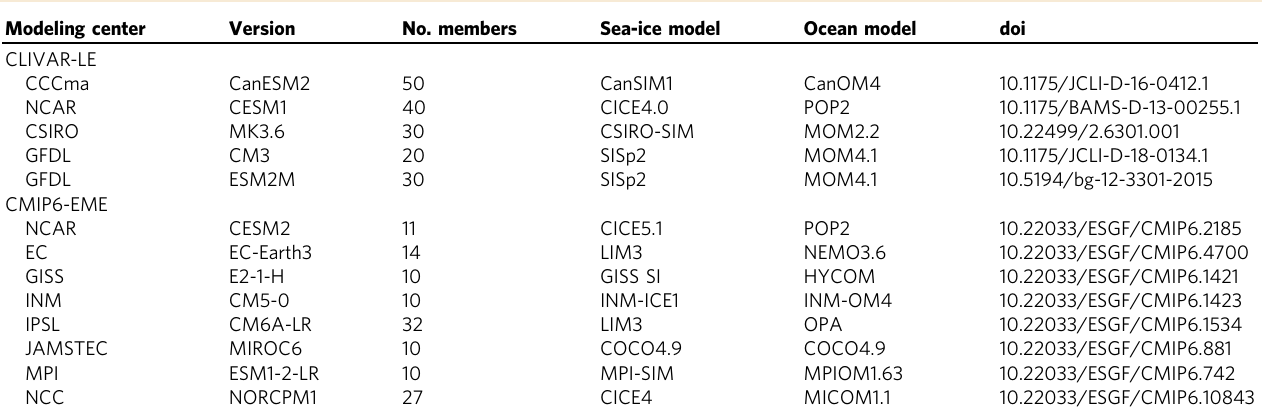
Table 1 Global climate models used in this